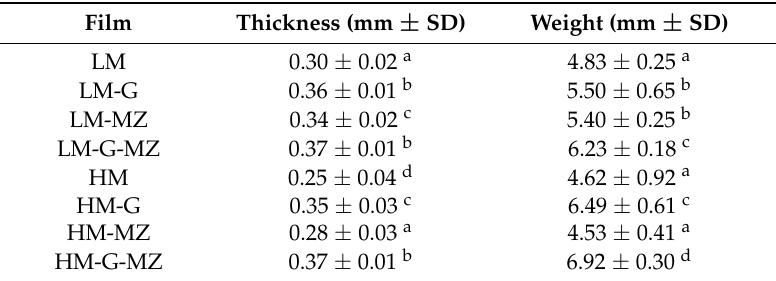
Figure 1. Morphology (left) and scanning electron microscopy of the surface (middle) and thickness (right) at 150× magnifications of LM ( a ) , LM-G ( b ), LM-MZ ( c ), LM-G-MZ ( d ), HM ( e ), HM-G ( f ), HM-MZ ( g ), and HM-G-MZ ( h ), LM: Low methoxyl pectin film; G: Glycerin; MZ: Metronidazole; HM: high methoxyl pectin film. Table 2 . Film thickness and weight variation.